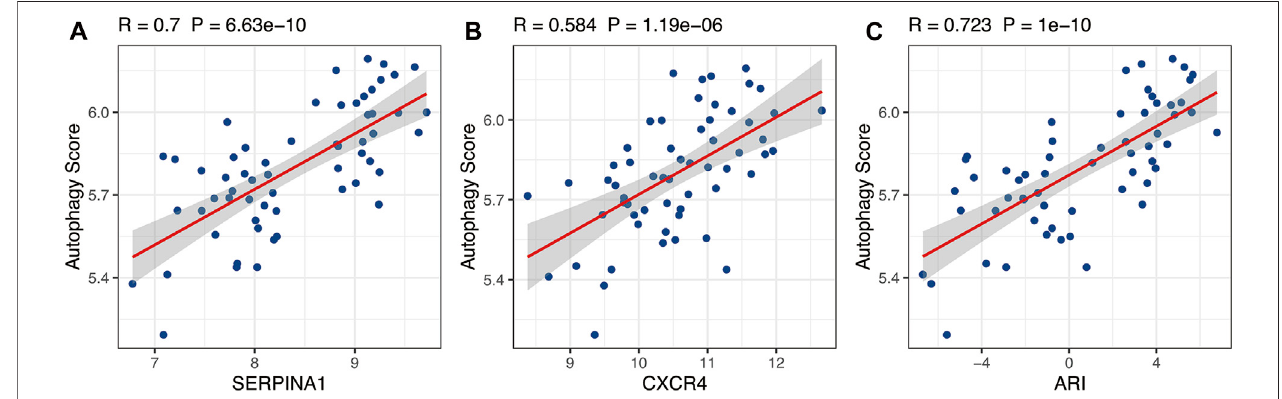
FIGURE 5 | The relationship between autophagy score and SERPINA1 , CXCR4 , and ARI. SERPINA1 , CXCR4 , and ARI were positively correlated with autophagy level based on Pearson correlation analysis. ARI, autophagy-related index.